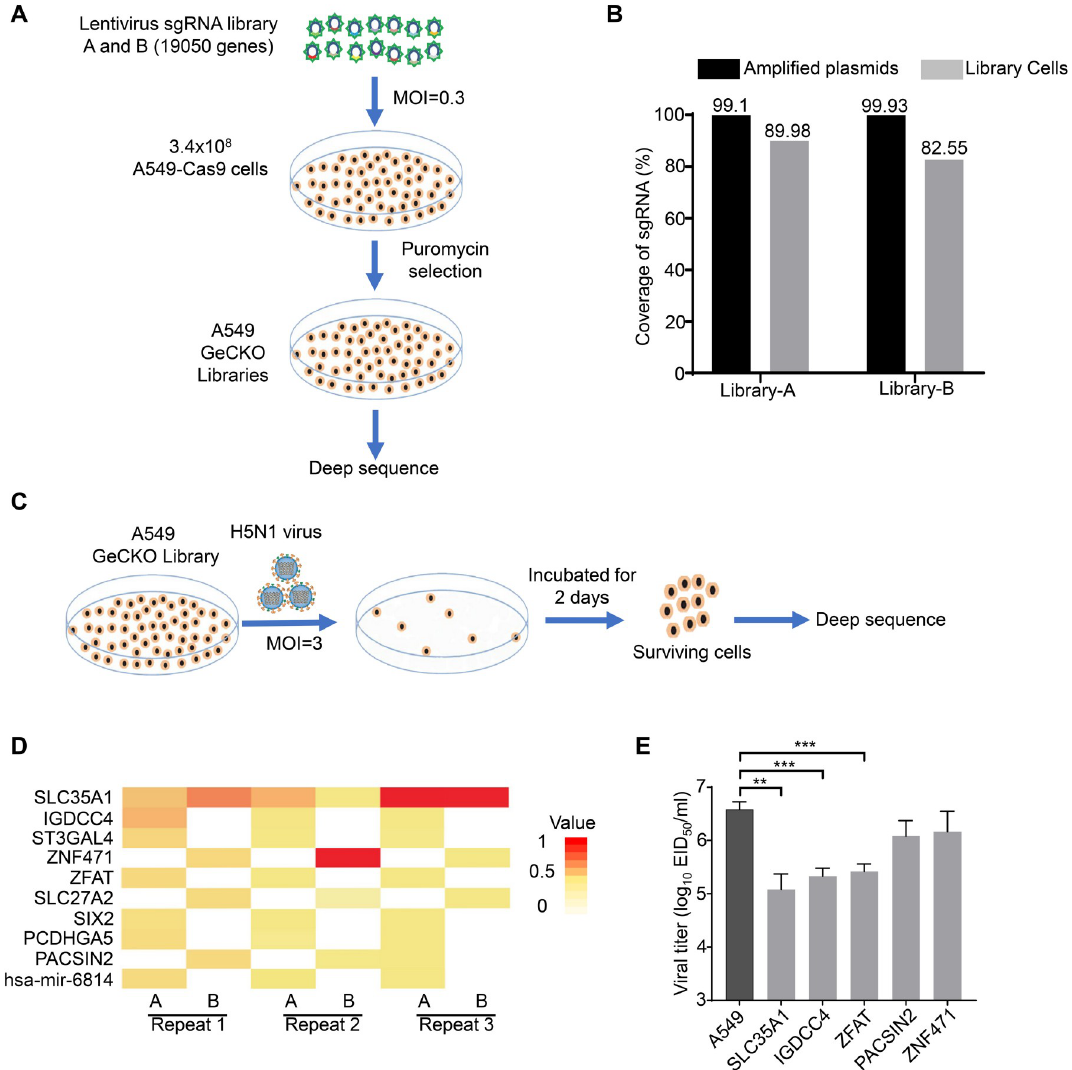
Fig 1. Genome-wide CRISPR/Cas9 screening of A549 cells for host factors required for highly pathogenic H5N1 influenza virus infection. ( A ) Schematic of the generation of the A549-GeCKO libraries by using lentivirus sgRNA libraries and A549 cells expressing Cas9 (A549-Cas9). A549-Cas9 cells were transduced with lentivirus containing sgRNA libraries A and B, respectively, and were maintained in puromycin for 14 days to generate the A549-GeCKO library, which was then deep sequenced. ( B ) Coverage of amplified library plasmids and GeCKO library cells compared with sgRNA lists from Addgene detected by high-throughput sequencing. ( C ) Schematic of screening host factors associated with H5N1 virus infection. ( D ) The heat map plots showing sgRNA abundance of the selected host factors in different screens. ( E ) H5N1 virus replication titers in different gene knockout cells. The cells were infected with H5N1 virus at an MOI of 0.01; the supernatants were collected at 48 h post-infection for viral titration in chicken embryos. The data shown are the means ± SDs of three biological repeats. The two-tailed unpaired t -test was used for the statistical analysis. �� , p < 0.01, ��� , p < 0.001. intracellular protein. Compared with isoform 1, isoform 2 lacks 270 amino acids at the N-ter- minus, and its 61 amino acids at the N-terminus differ from amino acids 271–331 of isoform 1 (Fig 2A). The function of IGDCC4 in viral replication has never been studied. We therefore further investigated the effect of IGDCC4 on influenza virus infection. An IGDCC4 knockout A549 cell clone (IGDCC4-KO) was generated by using CRISPR/Cas9 and knockout of both IGDCC4 isoform 1 and isoform 2 was confirmed by Western blotting with a mouse anti-